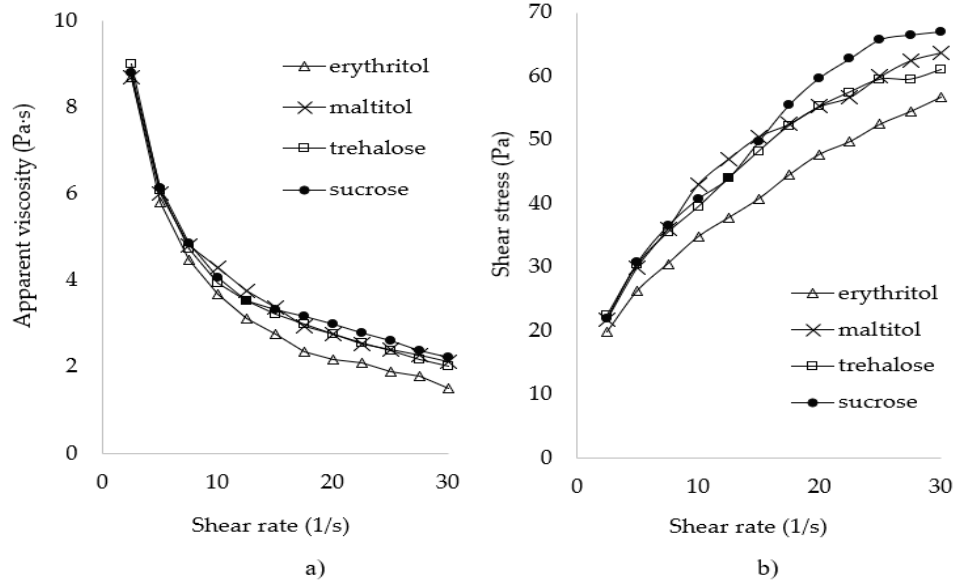
Figure 1. Rheological properties of the dough with sweetener: ( a ) viscosity curve; ( b ) flow curve. The occurrence of the phenomenon of shear thinning may be explained by the process of dough structure damage. Shear thinning of a sample at an increasing rate results in damage to and the coalescence of air bubbles [30]. In addition, the rate of disruption of the existing intermolecular bonds is higher than the rate of their formation [31]. When the stress increases, the values of the shear force may exceed the values of the forces of the structure-forming interactions, thereby leading to material structure reorganization